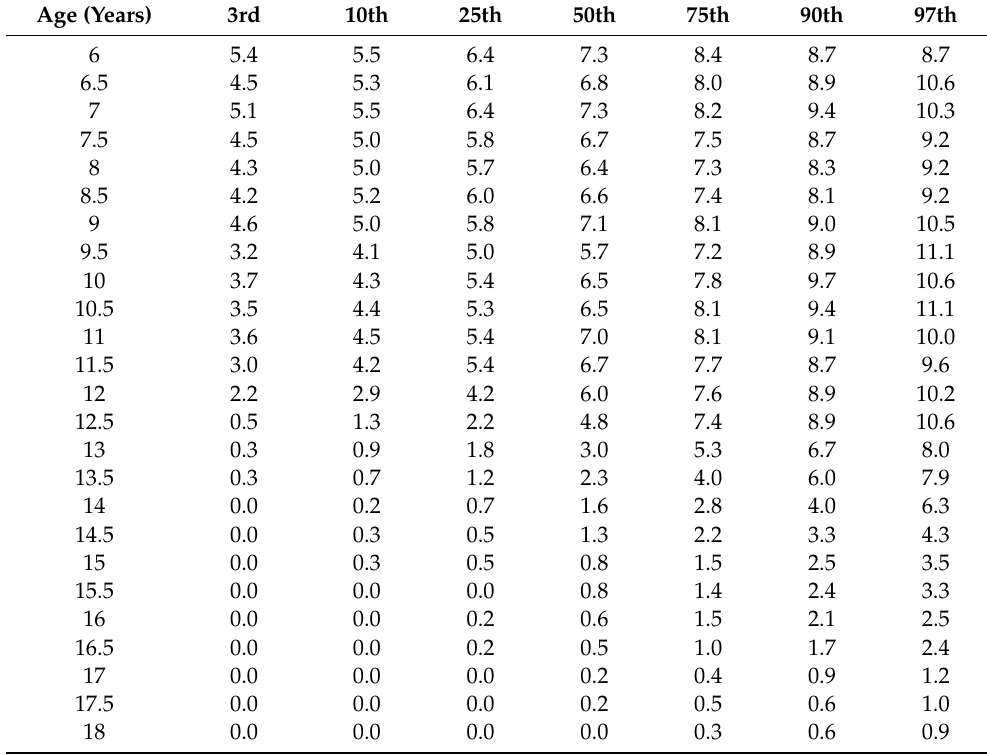
Table 4. Height velocity percentiles of schoolgirls 6–18 years